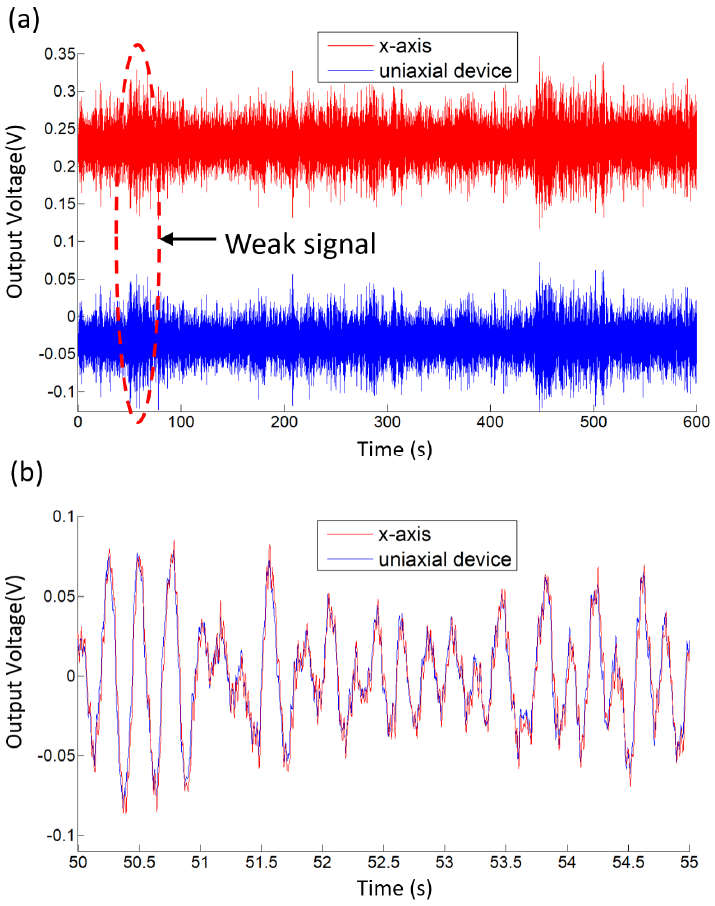
Figure 9. Test results of the integrated triaxial electrochemical seismometer developed in this study in comparison with the uniaxial electrochemical seismometer without observable ground motions, including ( a ) the time-domain response and ( b ) enlarged view of the normalized time-domain response from 50 to 55 s.